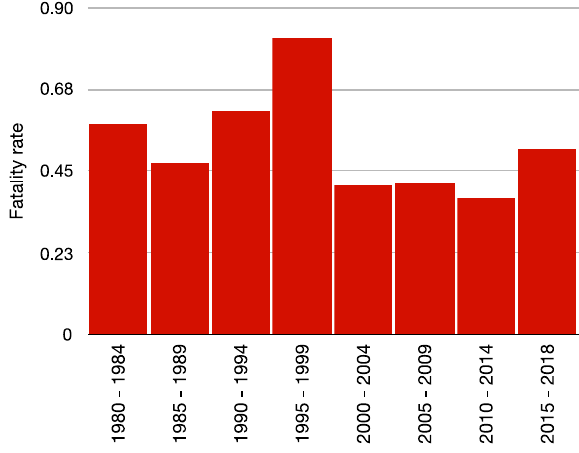
Figure 17. Mean F per five-year periods (all MEFF v2.0 DB regions).